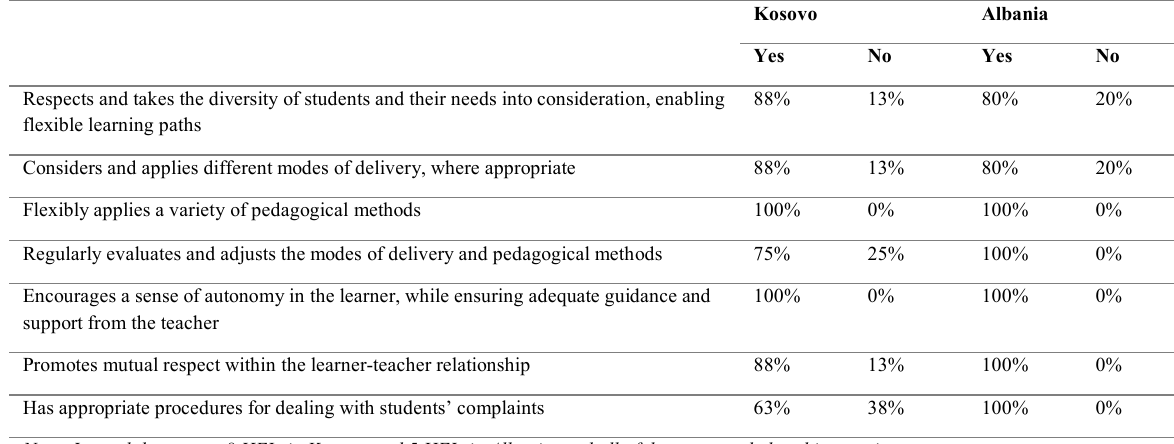
Table 3: Internal quality assurance: Student-centered learning, teaching and assessment